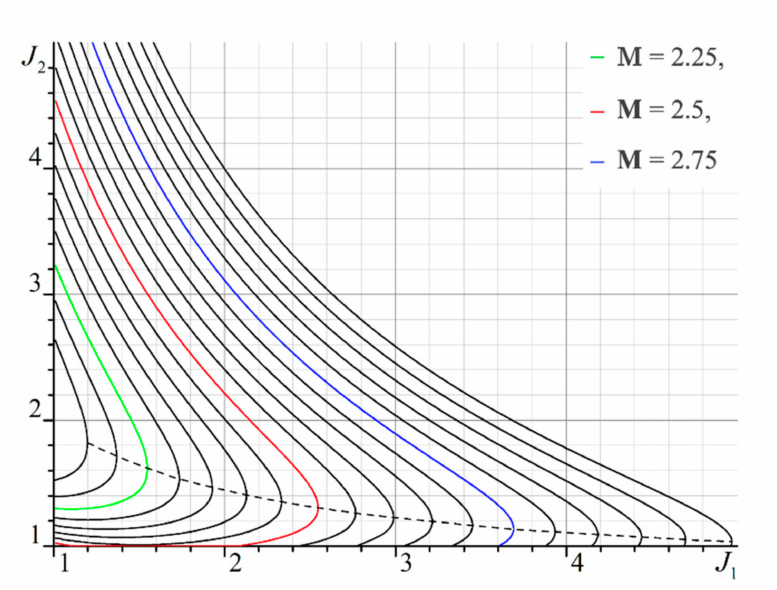
Figure 12. Lines J 1 – J 2 , corresponding to the characteristic shock wave structure in the range of Mach numbers M = 2.15–3, γ = 1.4.